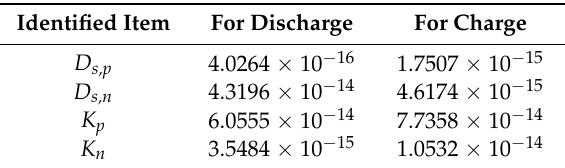
Table 2. Identified items for healthy battery.